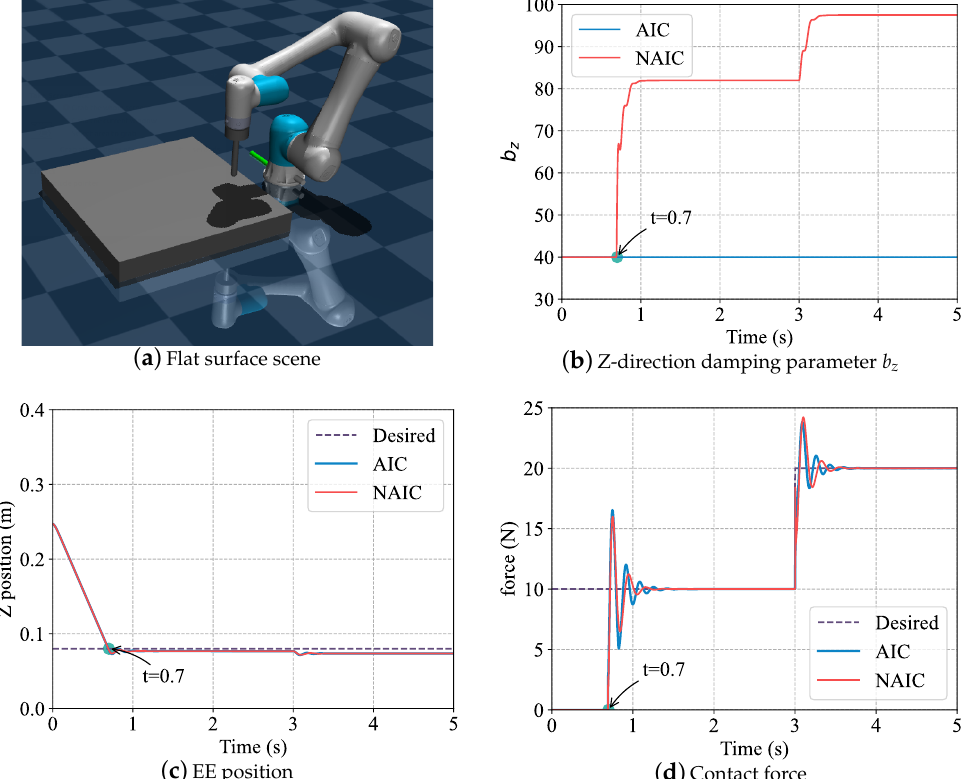
Figure 2. Force tracking simulation in flat surface. ( a ) Simulation scene. ( b ) Adaptive effect of damping parameters in the Z-direction. ( c ) The legend Desired means the environment position, which is 0.08 m. ( d ) Force tracking result. When t = 3 s, the desired force suddenly changes to f d = 20 N, and the error between EE position and surface height increases.